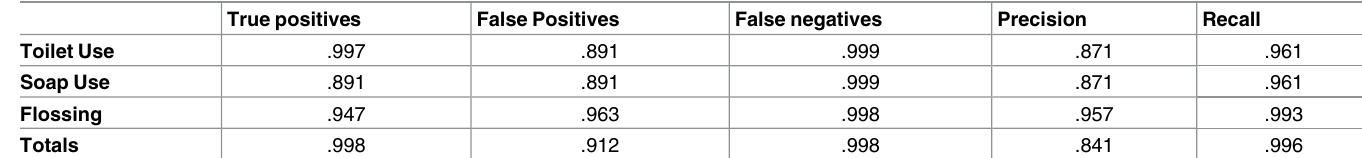
Table 4. Intra-class coefficients for the reliability of the measurements for the different types of behaviour between the two raters.